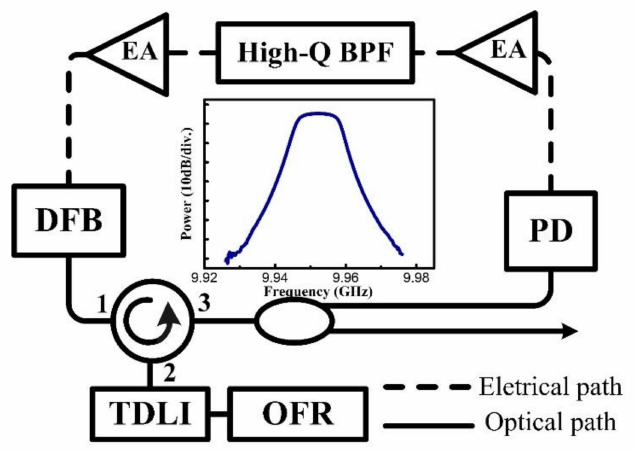
Figure 2. Experimental setup of OEO-based multi-wavelength generation (DFB: distributed feedback laser, TDLI: tunable delay interferometer, OFR: optical fiber reflector, PD: photodetector, EA: electrical amplifier, High Q BPF: High-Q bandpass filter).